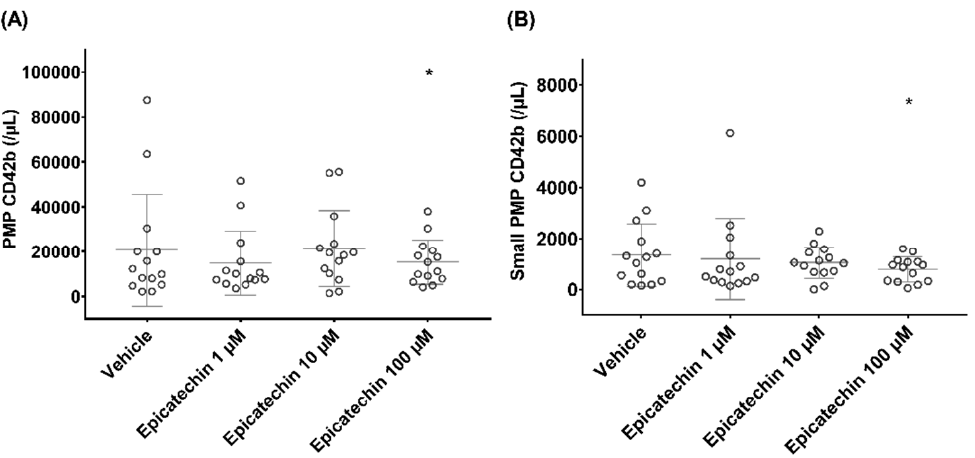
Figure 1. Impact of epicatechin on the concentration of platelet microparticles (PMPs) that express glycoprotein Ib. ( A ) Total PMP population. ( B ) Small PMP subpopulation. * Significant effect of intensity.